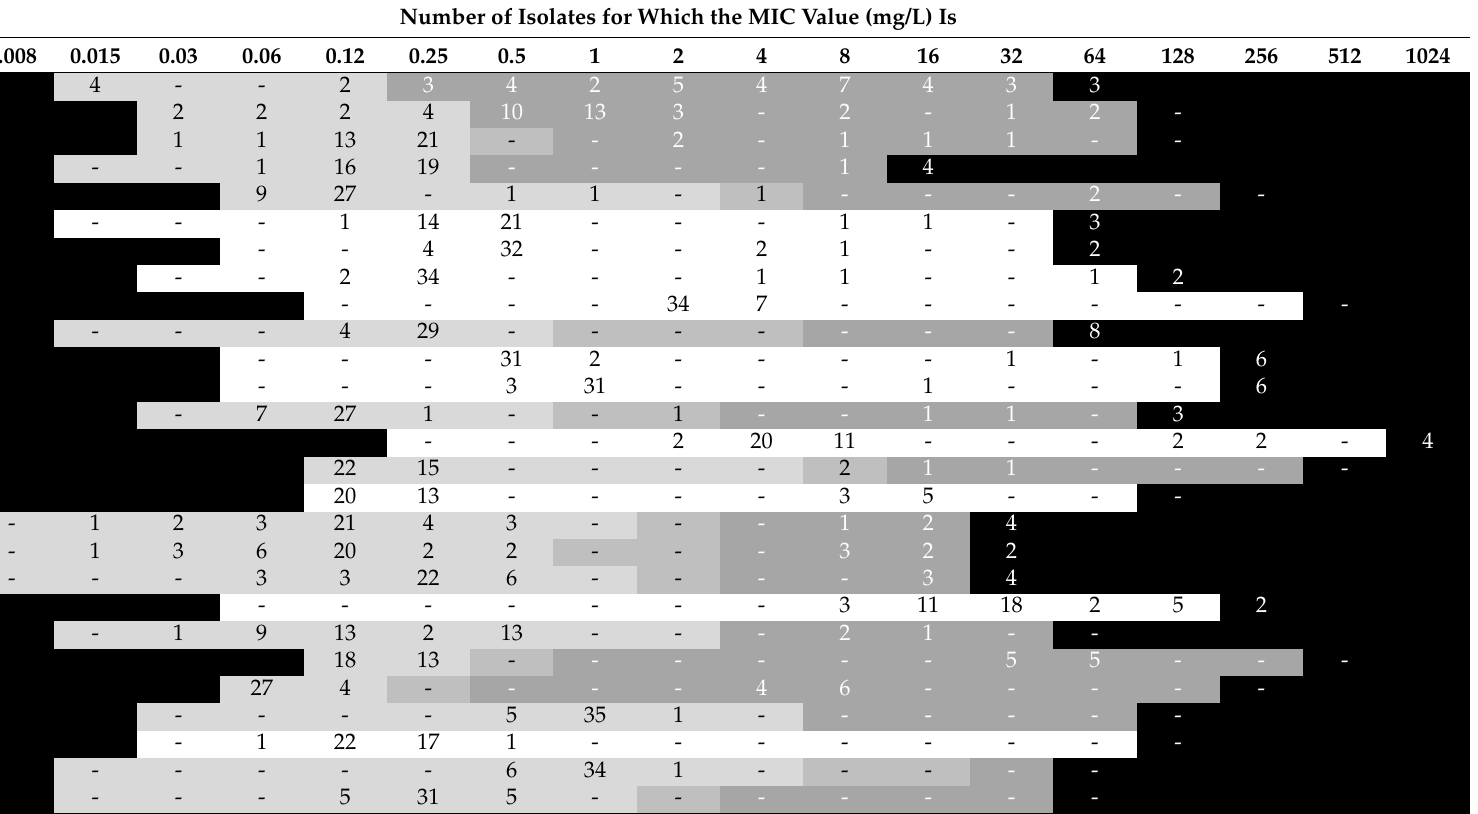
Table 4. Minimal inhibitory concentrations of the 41 canine S. pseudintermedius